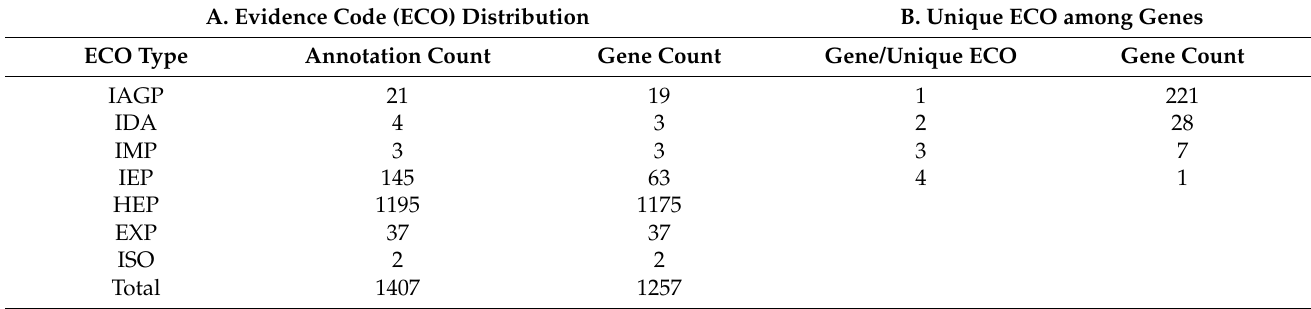
Table 1. Evidence code analysis of COVID-19 disease annotations and associated genes.